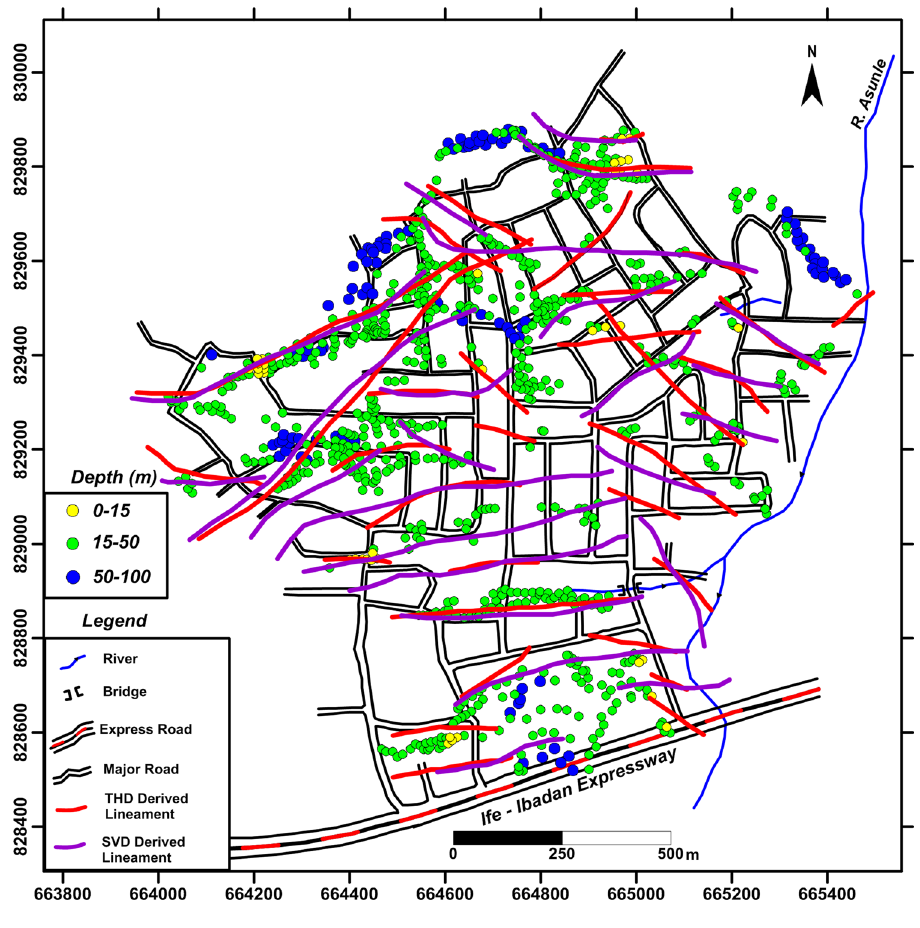
Fig. 9 Map showing the 3D Euler solution and superim- posed THD and SVD derived